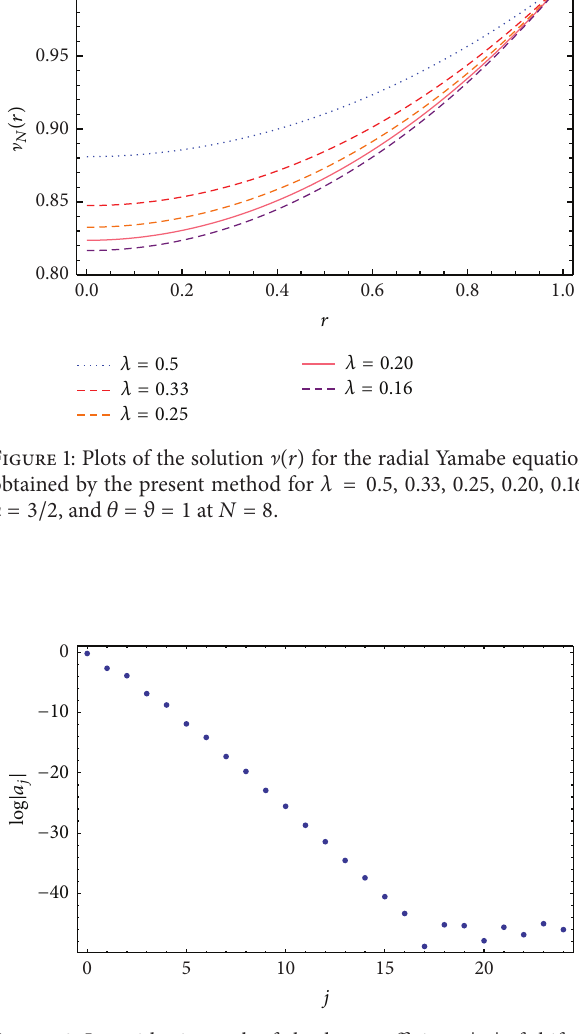
Figure 2: Logarithmic graph of absolute coefficients |𝑎 𝑗 | of shifted Jacobi polynomials for 𝑛 = 3/2 , 𝜆 = −0.5 , and 𝛼 = 𝛽 = 1 at 𝑁 = 24 .